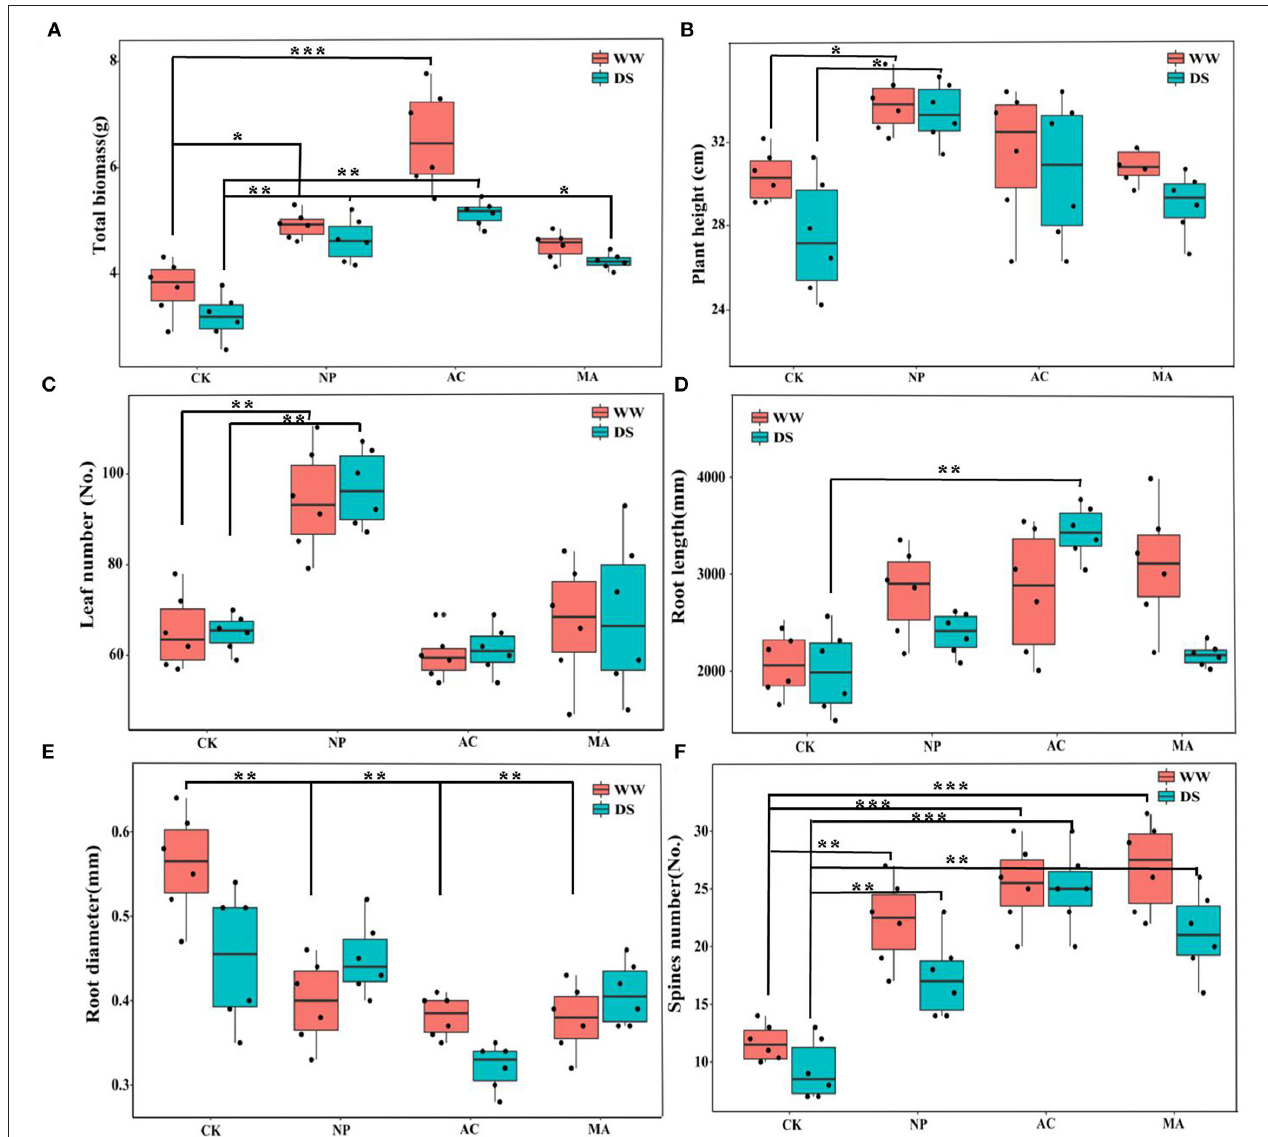
FIGURE 2 | Effect of different dark septate endophytes (DSE) on morphological parameters of growth of Lycium ruthenicum seedlings. CK, non-inoculated plants; NP, plants inoculated with Neocamarosporium phragmitis ; AC, plants inoculated with Alternaria chlamydospore ; MA, plants inoculated with Microascus alveolaris ; WW, well-watered; DS, drought stress, respectively. The total biomass of Lycium ruthenicum seedlings (A) , Plant height of Lycium ruthenicum seedlings (B) , Leaf number of Lycium ruthenicum seedlings (C) , Root length of Lycium ruthenicum seedlings (D) , Root diameter of Lycium ruthenicum seedlings (E) , and Spines number of Lycium ruthenicum seedlings (F) . The * symbol indicates the significant difference P < 0.05. The ** symbol indicates the significance level intervenes between P < 0.01. The *** symbol indicates difference is very significant, P <